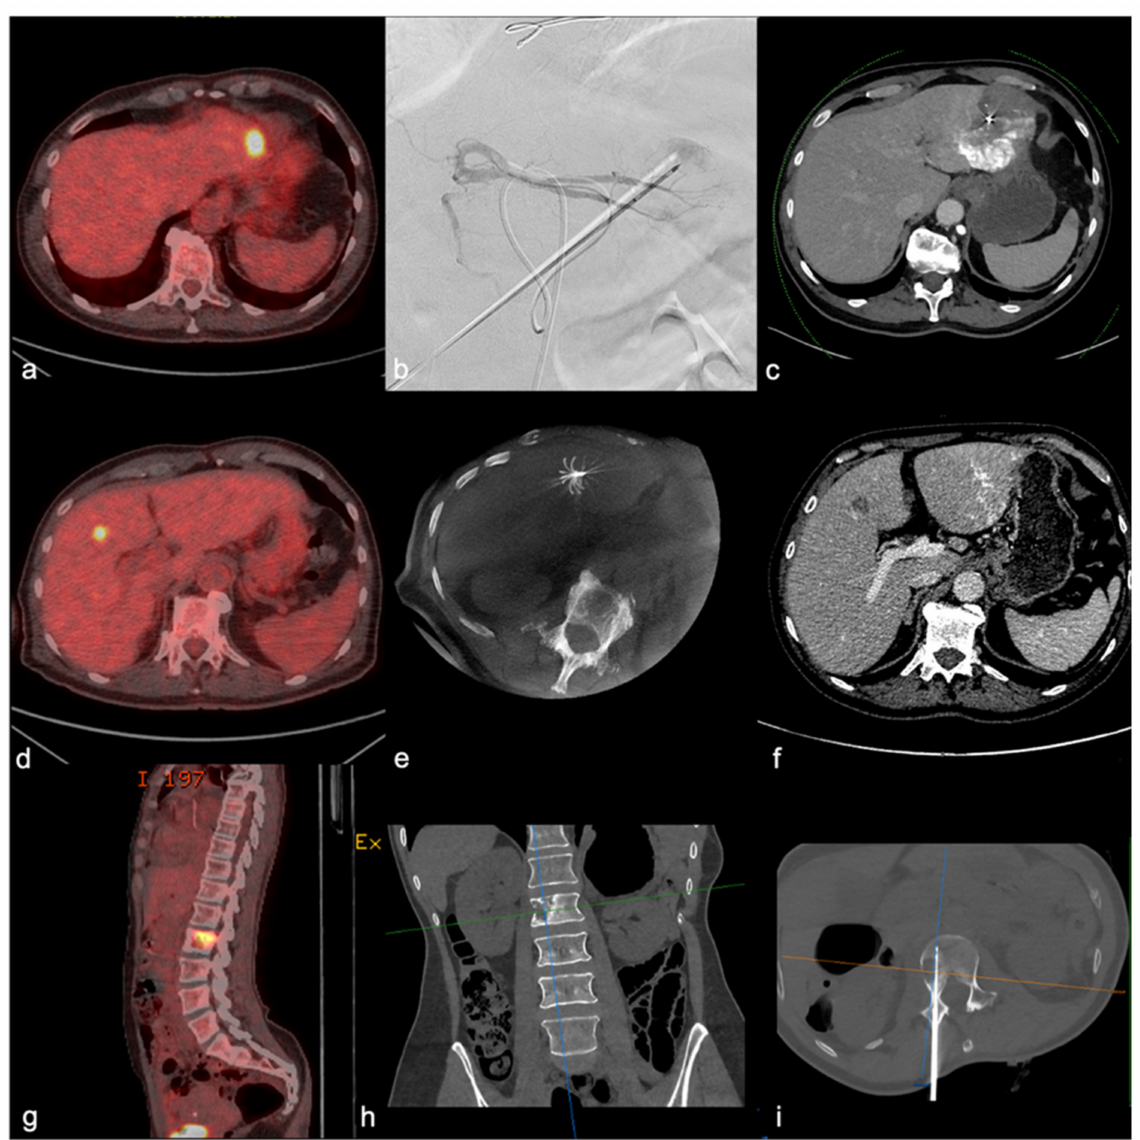
Figure 4. Iterative local treatments (LT): a 60-year-old woman with a history of stage IVa ACC with metachronous metastasis 14 months after mitotane initiation: ( a ). an axial PET-CT showing a two-centimeter FDG uptake within the third hepatic segment. ( b ). Fluoroscopy image of combined treatment with the association of chemoembolization and cryotherapy. ( c ). Six-week follow-up axial CT showing lipiodol uptake and no nodular contrast enhancement, in favor of complete response. ( d ). Axial PET-CT at 7 months of the first LT showing new centimetric FDG uptake within the fourth segment. ( e ). Radiofrequency ablation guided by ultrasound and CBCT with a deployable needle. ( f ). Contrast-enhanced follow-up CT at 6 weeks of the second LT showing unenhanced low-density ablation zone. ( g ). Axial PET-CT 6 months after the second LT (24 months from mitotane systemic treatment) depicting L2 nodular FDG uptake. ( h ). Non-contrast CT coronal view of a L2 lytic lesion. ( i ). Radiofrequency ablation of L2 vertebral body using a straight